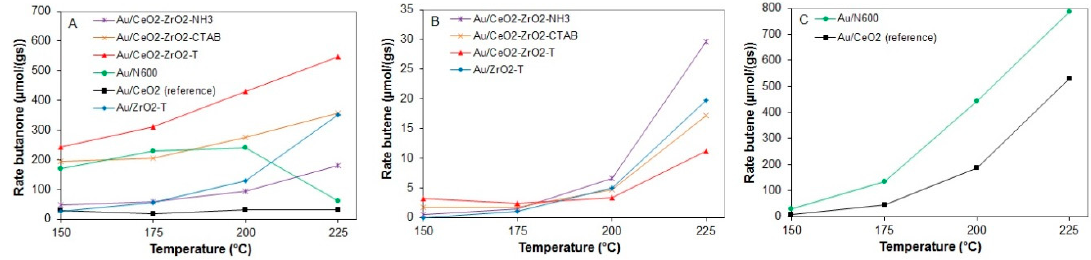
Figure 17. Rates of butanone ( A ) and butene ( B , C ) from 2-butanol conversion at 150 to 225 °C for various pre-treated gold supported catalysts.